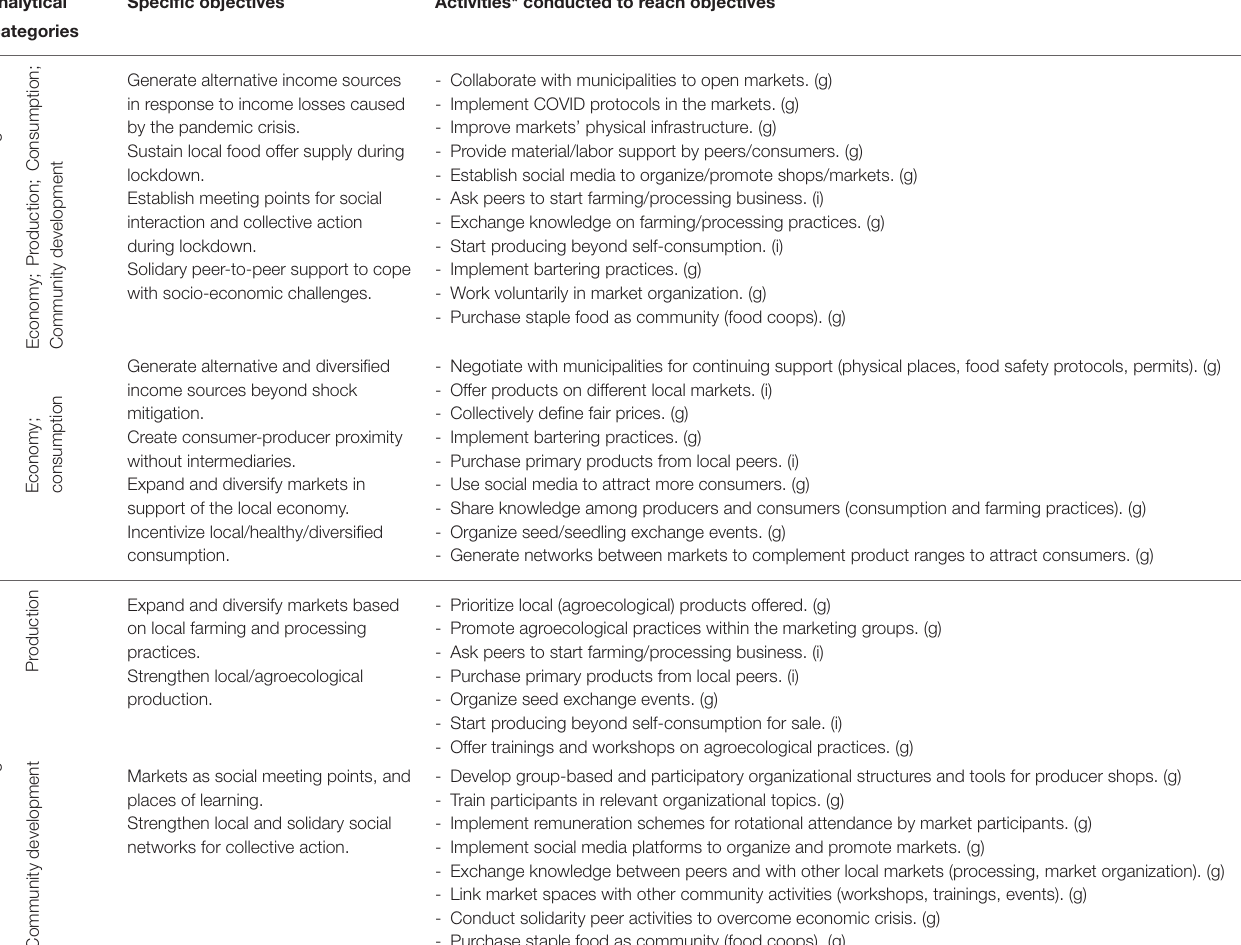
TABLE 1 | Objectives and activities of the SOPGs. Analytical Specific